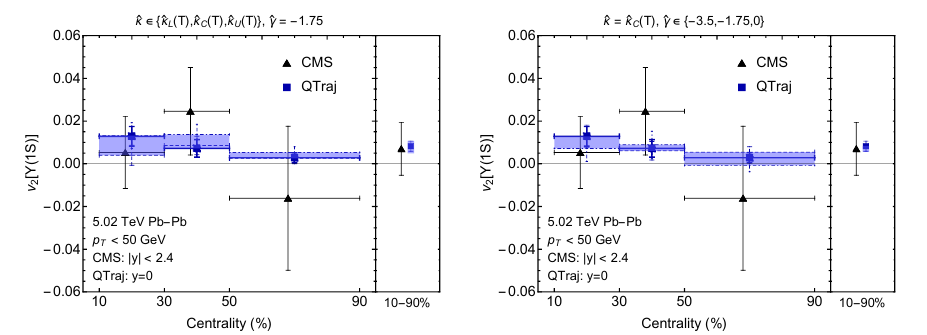
Figure 3. (Color online) The elliptic flow v 2 of the Υ (1 S ) as a function of centrality compared to Figure 2. (Color online) The double ratio of the nuclear modification factor R AA [ Υ (2 S )] to R AA [ Υ (1 S )] experimental measurements of the CMS [32] collaboration. The QTraj bands represent uncertainties as as a function of N part compared to experimental measurements of the ALICE [23], ATLAS [24], and in Fig. 1. QTraj error bars indicate the statistical uncertainty of our CMS [31] collaborations. The bands indicate variation of ˆ κ ( T ) and ˆ γ as in Fig. 1. The black and red experimental error bars represent statistical and systematic uncertainties, respectively.